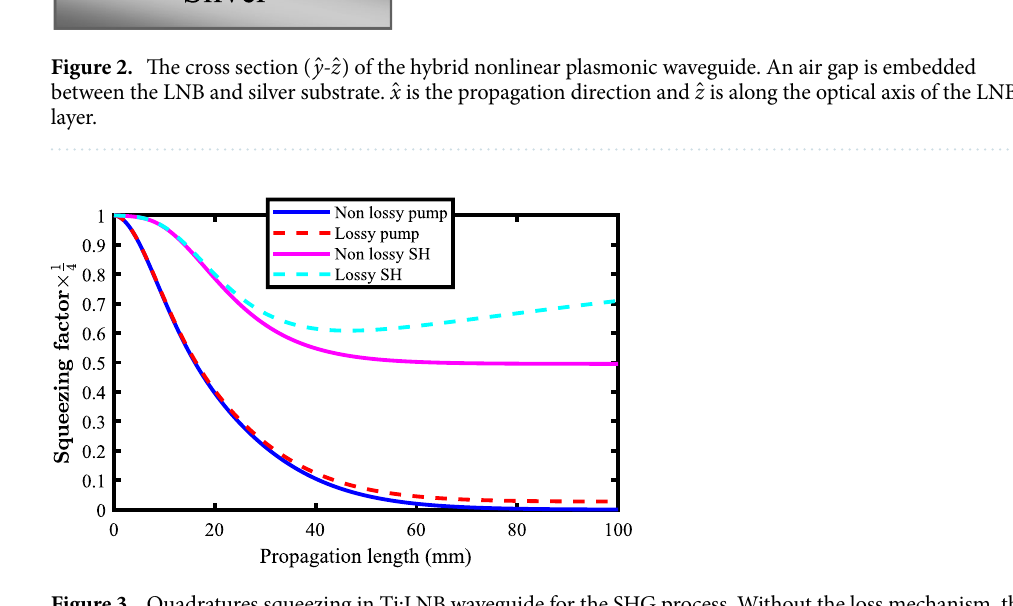
Figure 3. Quadratures squeezing in Ti:LNB waveguide for the SHG process. Without the loss mechanism, the pump mode (blue-solid line) squeezes unboundedly, while the SH mode (magenta-solid line) is squeezed to half its initial value. When the loss mechanism is included, the squeezing rate of the pump mode (red-dashed line) is limited and the SH mode (cyan-dashed line) de-squeezes due to accumulated